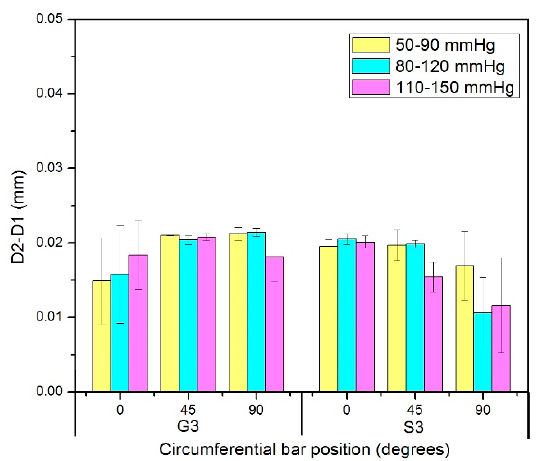
Figure 12. Diameter changes of stented zone S3 and unstented zone G3 of the nitinol-PET stent graft in three circumferential bar positions.